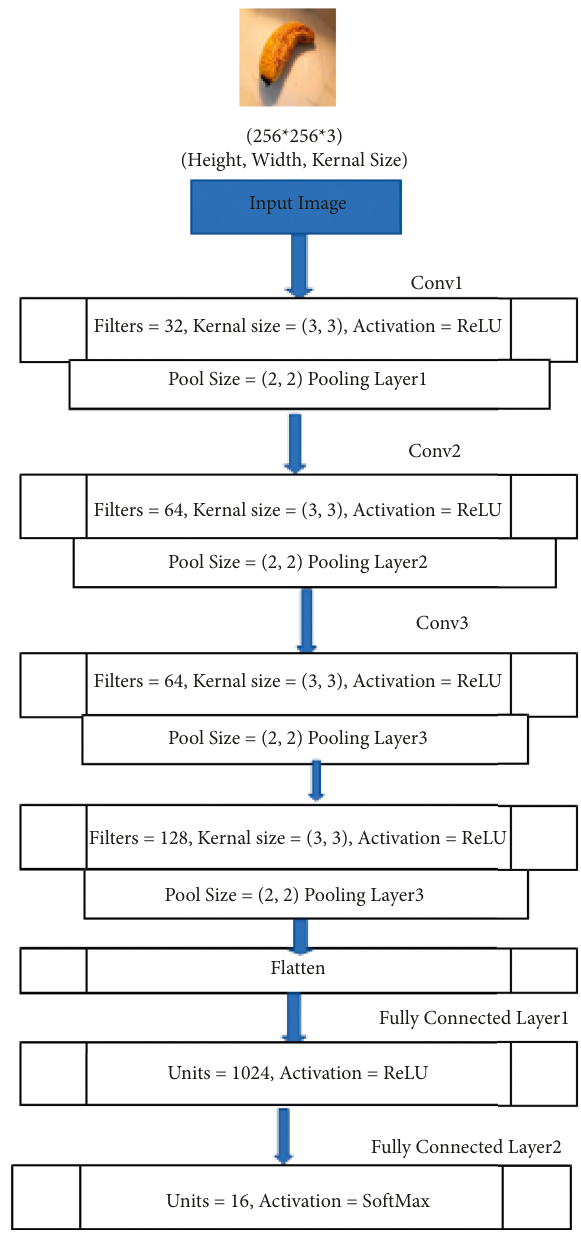
Figure 2: Proposed CNN model